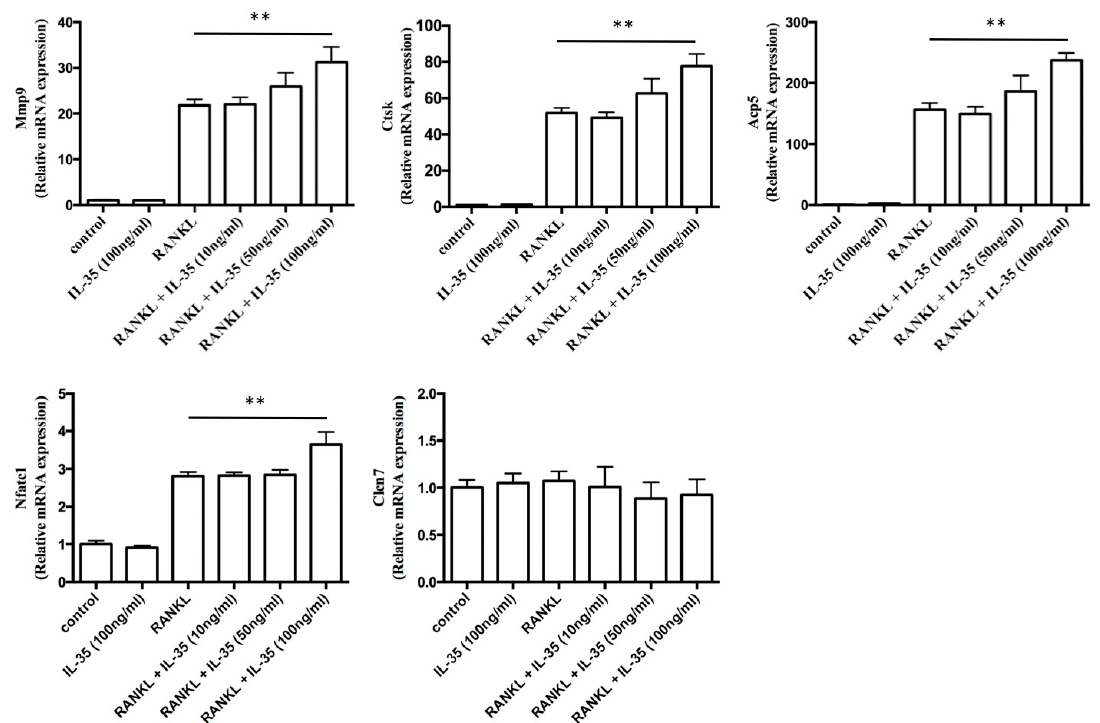
Figure 3. IL-35 synergistically induces expression of RANKL-dependent osteoclast-specific markers. matrix metalloproteinase (MMP)-9 (Mmp9), cathepsin K (Ctsk), TRAP (Acp5), nuclear factor of activated T cells (NFAT) c1 (Nfatc1), and chloride channel 7 (CLCN7) (Clcn7) mRNA expression was investigated in RAW cells stimulated with 50ng / mL RANKL together with or without 10, 50, or 100ng / mL IL-35 or 100ng / mL IL-35 alone for 2 days by qPCR. Values are expressed as fold changes. Di ff erences among groups were analyzed by two-way ANOVA. Data represent the mean ± SD ( n = 3). ** p < 0.01 vs. RANKL alone.